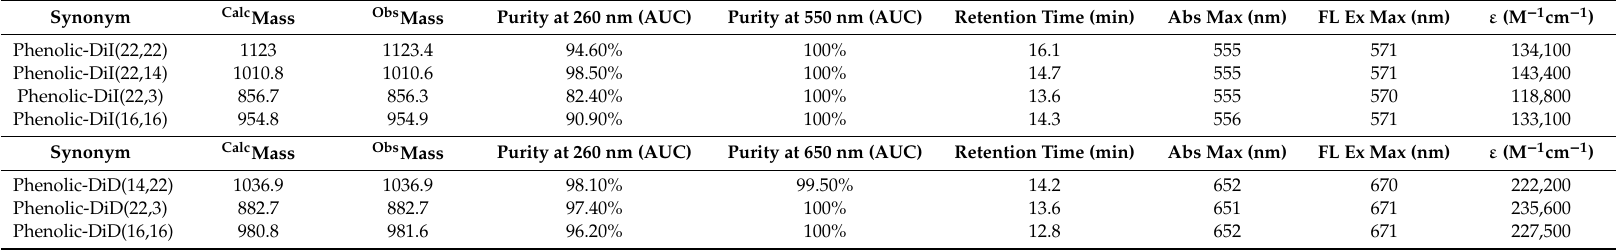
Table 1. Absorbance and fluorescence properties of each phenolic compound. The derivatives were characterized by a combination of proton NMR, low resolution MS, HPLC, UV-VIS and fluorescence